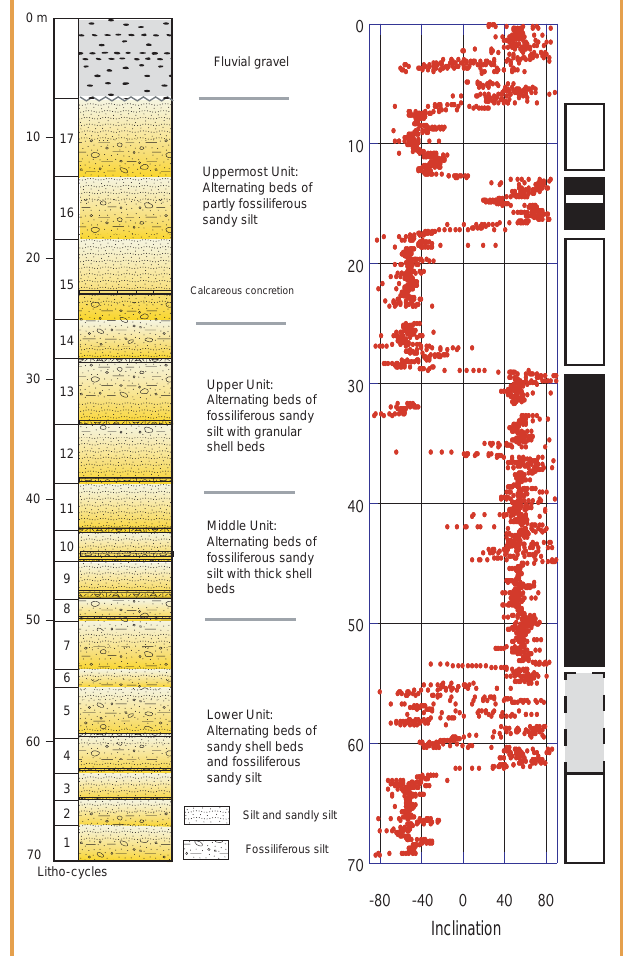
Figure 3. Lithostratigraphy and magnetostratigraphy of drilled core. Lithostratigraphic sequence comprised seventeen sedimentary cycles (left). Magnetostratigraphy with two normal and three reversed polarity zones